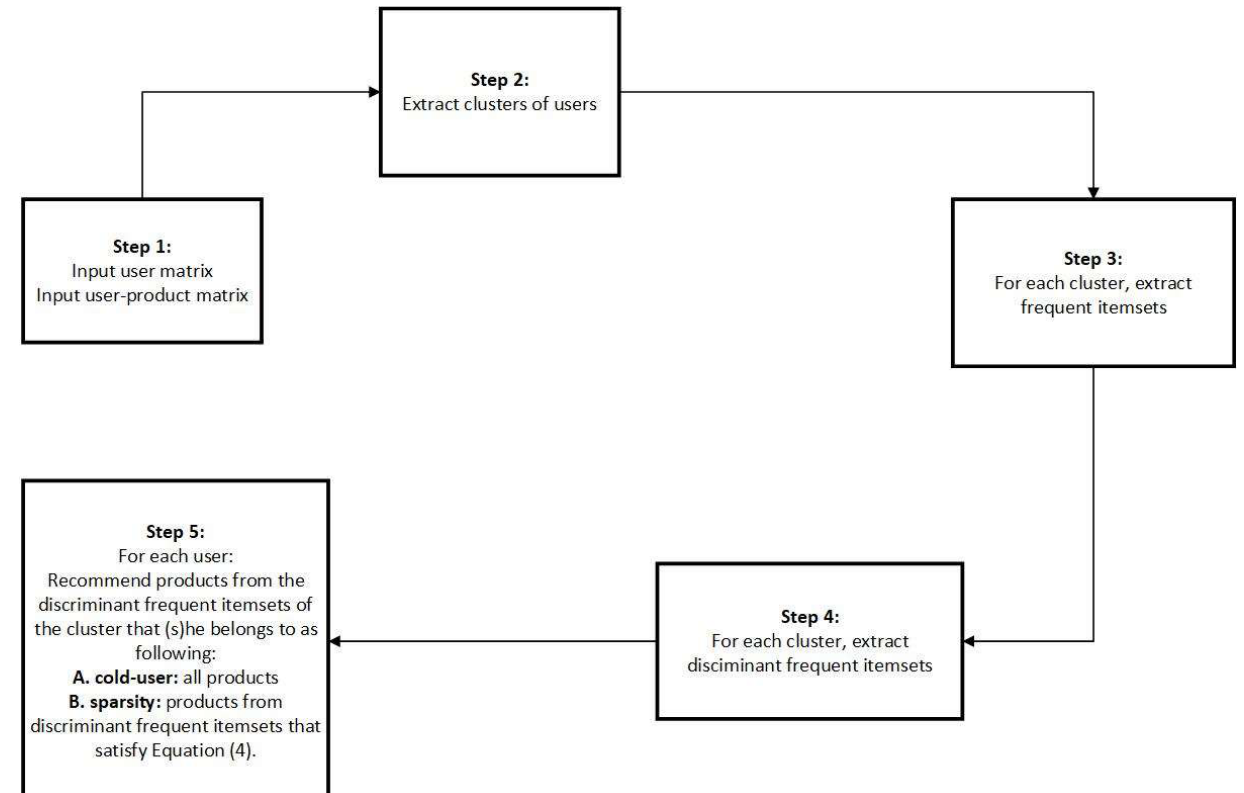
Figure 1. Proposed methodology.